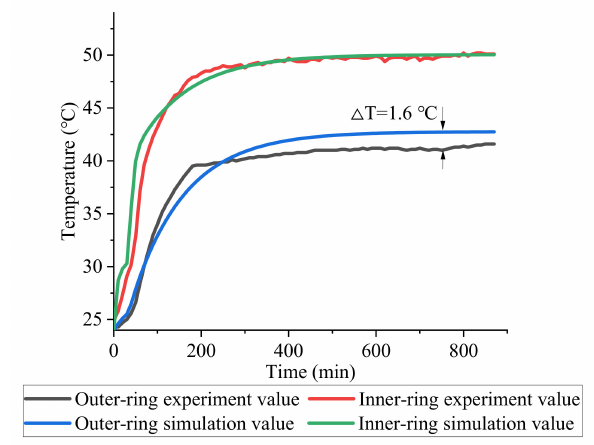
Figure 8. Durability experiment verification